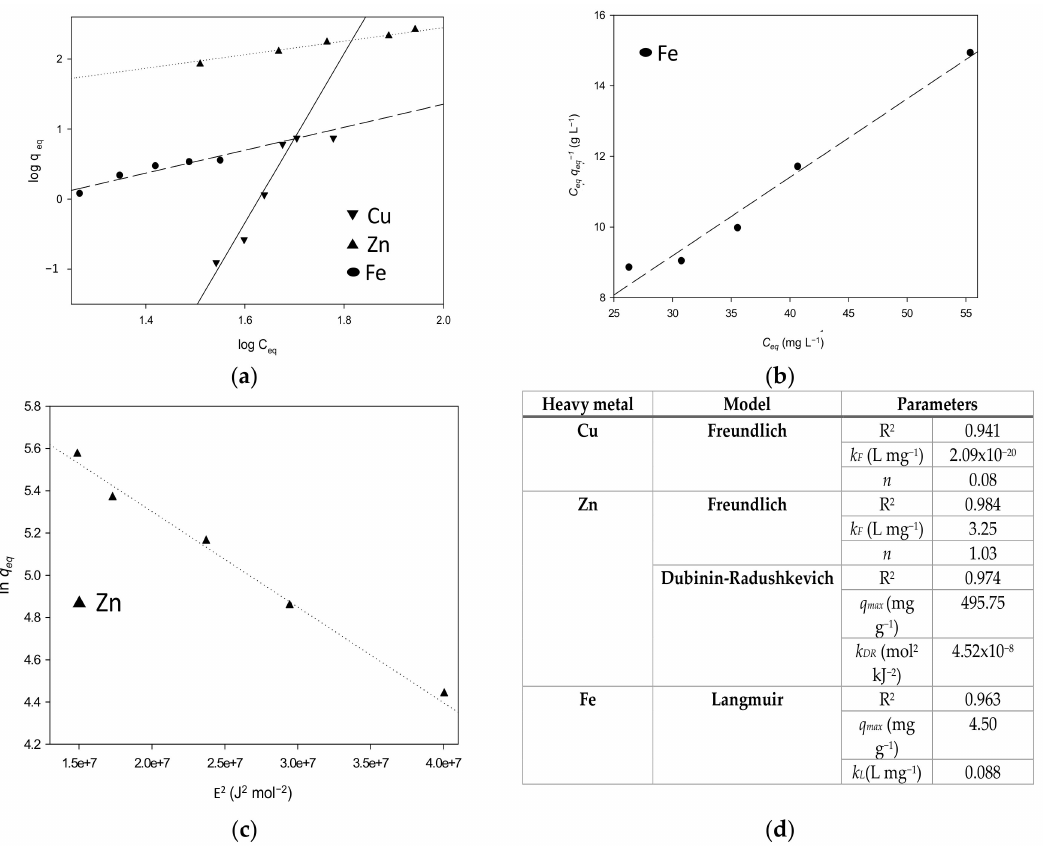
Figure 6. Adsorption experimental data fitted to isotherm models Freundlich ( a ), Langmuir ( b ), Dubinin-Radushkevich ( c ) and their equilibrium parameters ( d